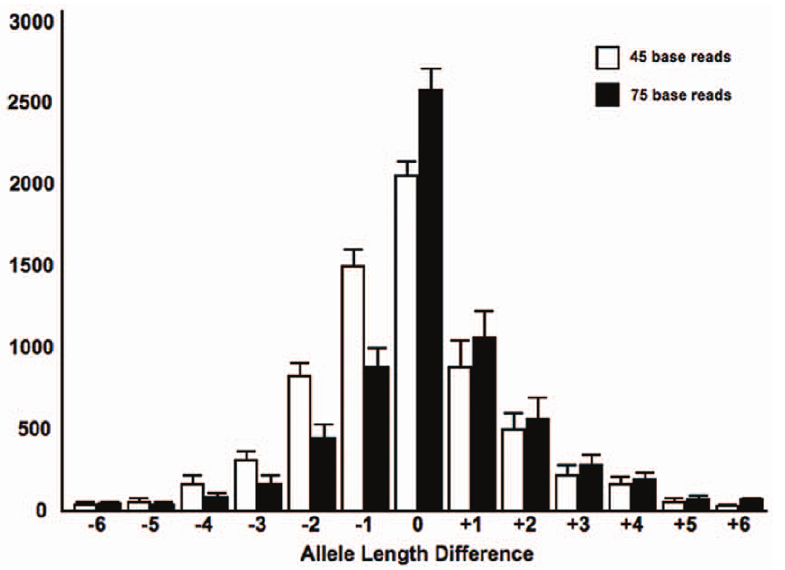
Figure 2. Analysis of discordant genotypes in genomes sequenced with two different read lengths reveals that short reads exhibit a bias towards shorter alleles. The difference between the inferred genotypes and the corresponding reference repeat length was tallied for 6,908 (out of 390,873) repeats for which different genotypes were obtained in the same inbred line from 45 base (open bars) versus 75 base (solid bars) reads. Permutation testing (1000 trials) indicates that the bias toward shorter alleles evident in the 45 base libraries is significant (for clarity, only the upper half of 95% confidence intervals are shown).